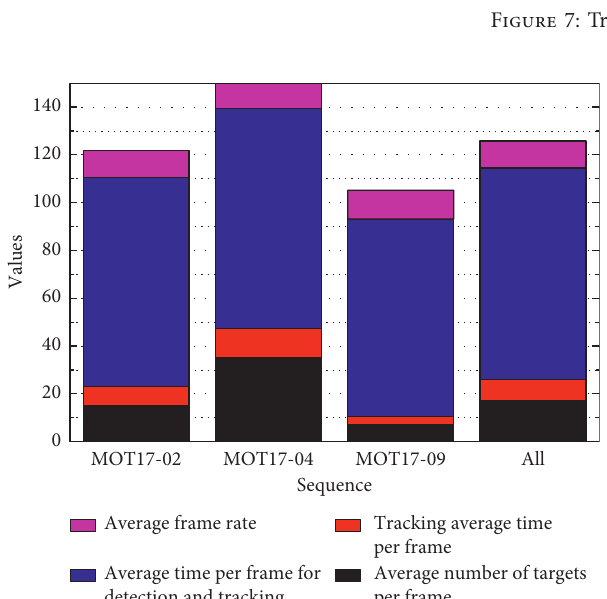
Figure 8: Test elapsed time and average frame rate of multitarget tracking algorithm on MOT17